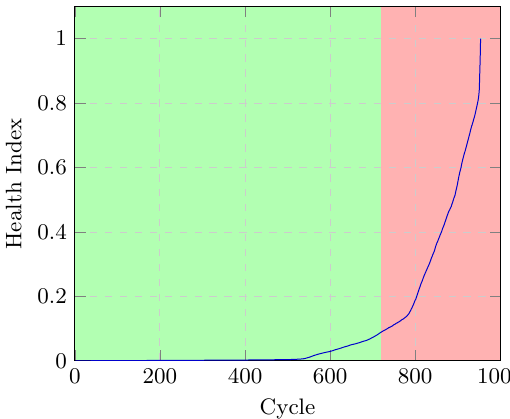
Figure 3. Health stage